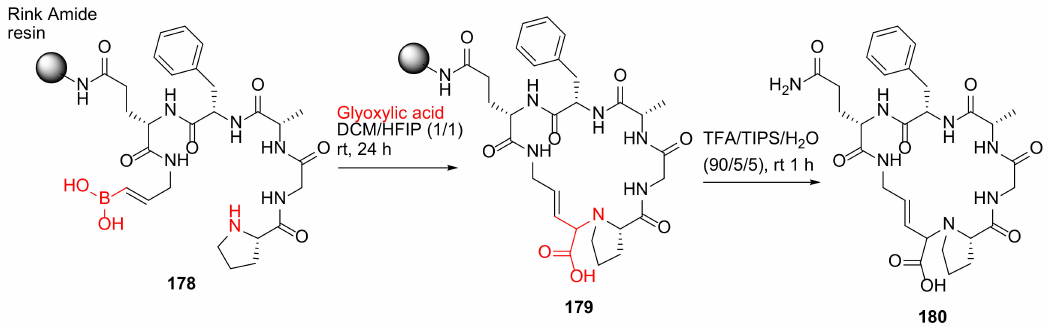
Scheme 54. On-resin synthesis of macrocyclic peptides via the Petasis borono–Mannich cycliza- tion strategy